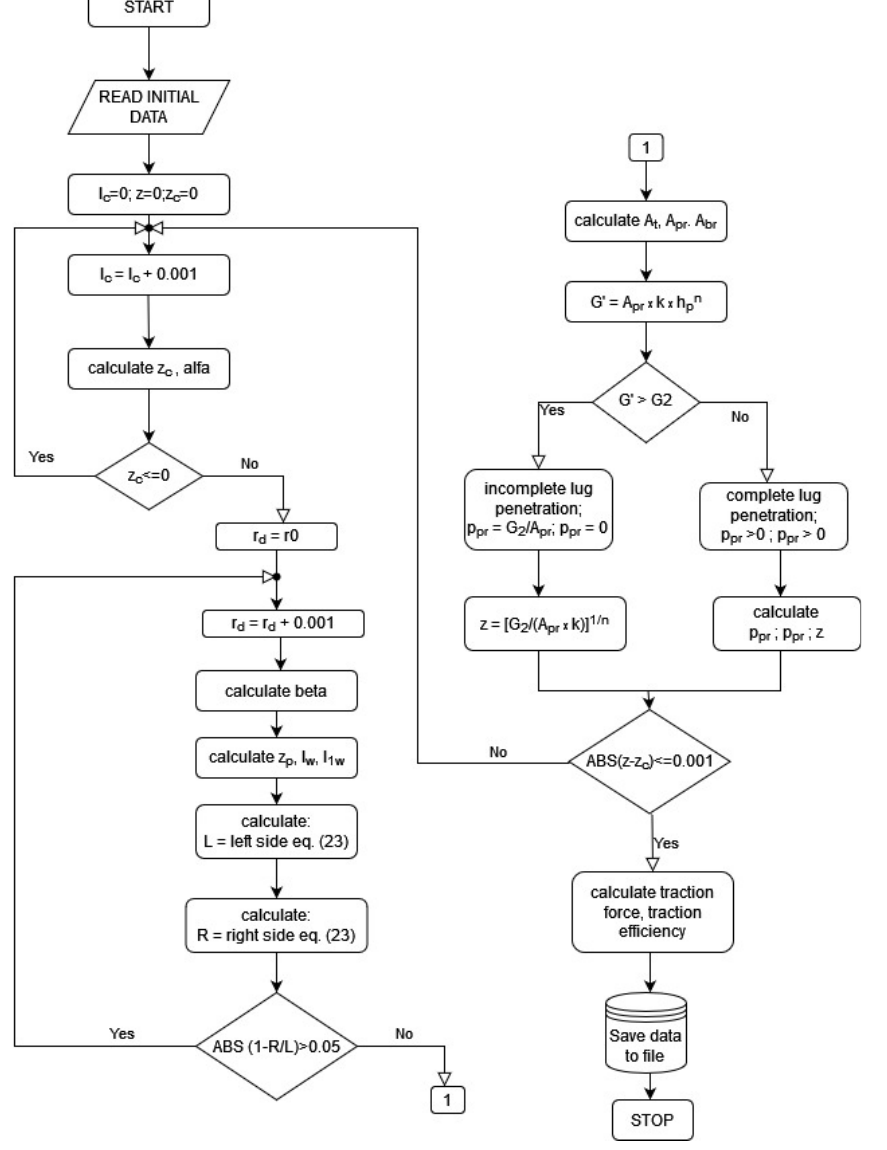
Figure 4. Flowchart of the computer program.